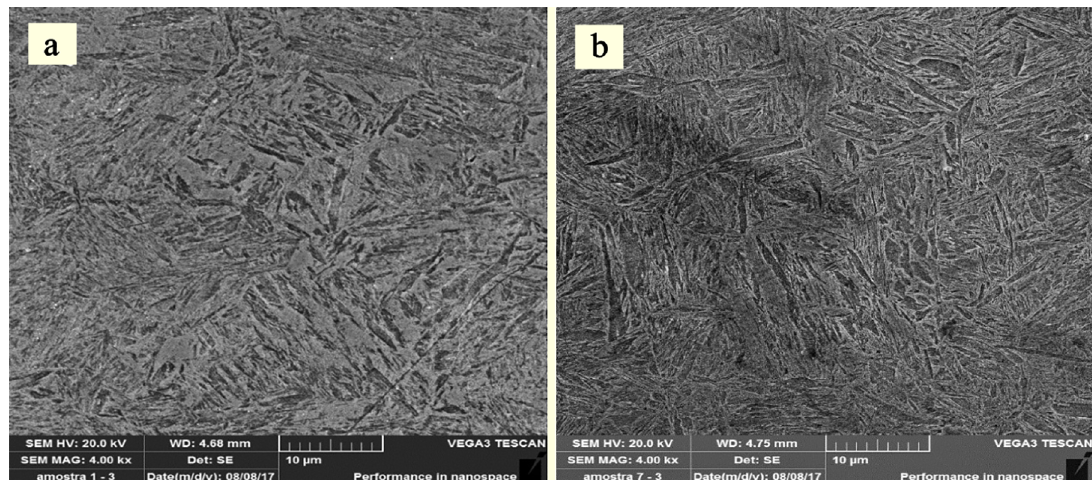
Figure 8. SEM observation of AISI 4340 steel cooled in water after the heat treatment: (a) 800 °C for 30 minutes and (b) 900 ˚C for 60